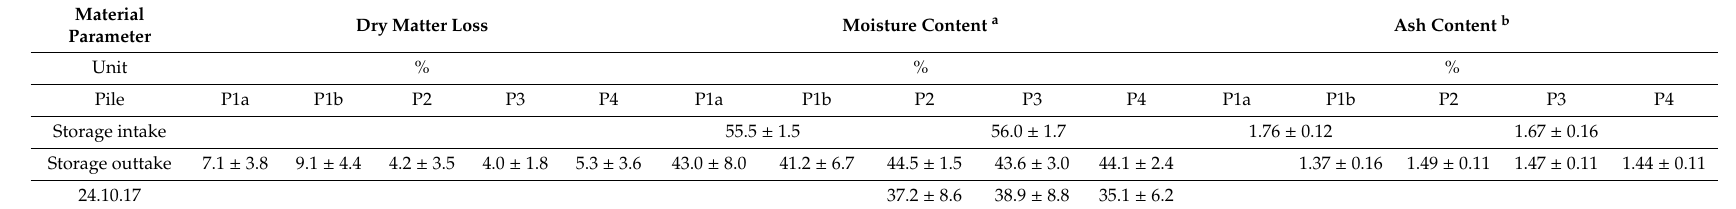
Table 4. Overview of mean material parameters ( ± standard deviation) at storage intake and